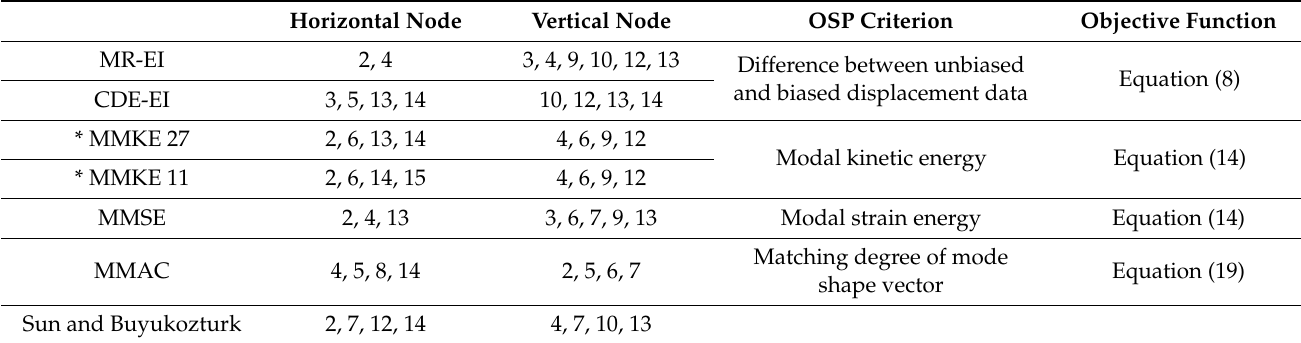
Table 1. Sensor layouts according to the OSP algorithms proposed in this work. Horizontal